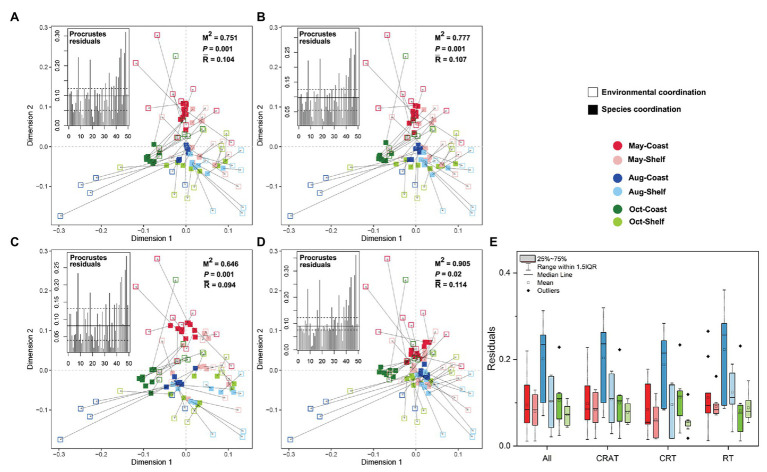
Procrustes analyses of the correlations between environmental PCA coordination and community compositions’ PCoA coordination (based on Bray-Curtis distances) of each taxa dataset (A. All; B. CRAT; C. CRT; and D. RT; M2, the Procrustes sum of squares; p, the significance under 999 permutations test; and R, the mean value of Procrustes residuals). The Procrustes residuals of each sample are shown at the left top and of six sampling groups are compared in the boxplot (E).